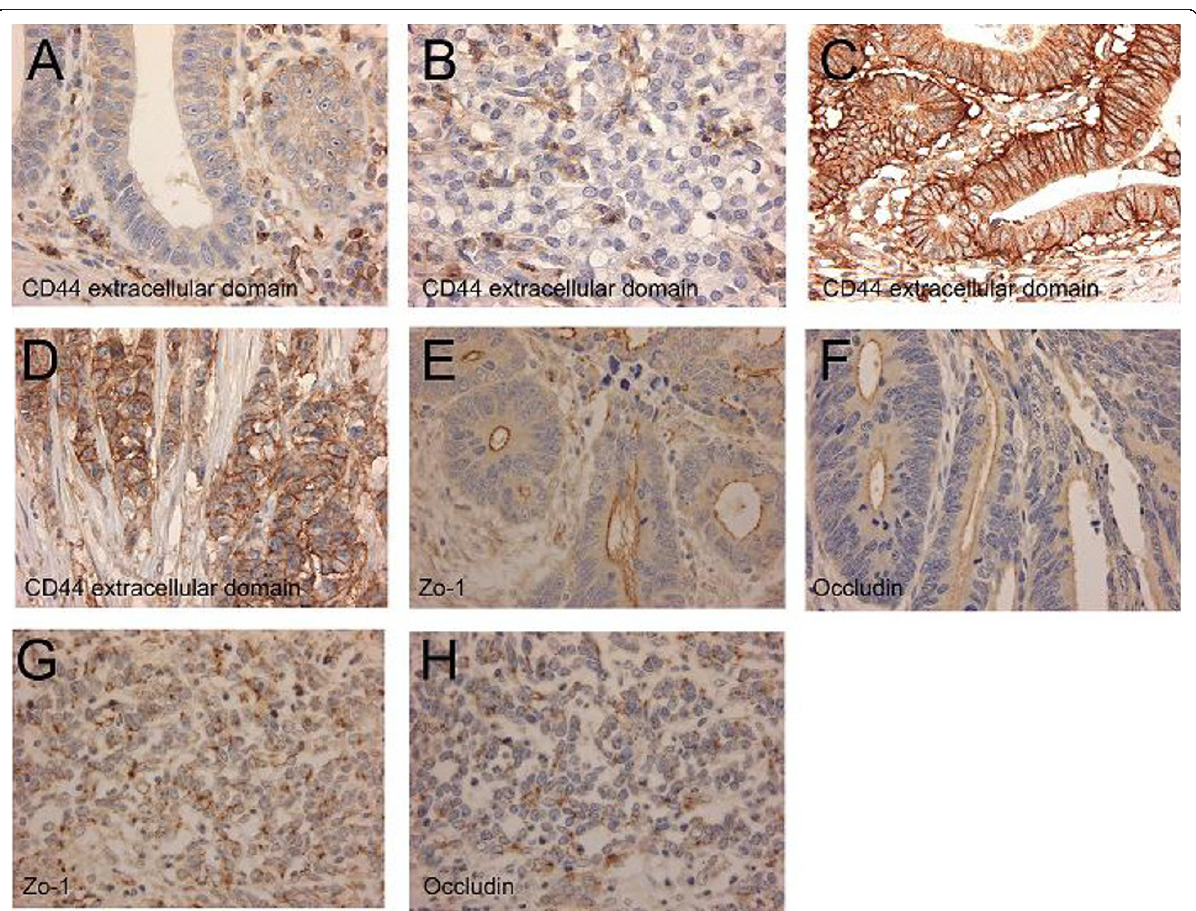
Figure 2 Representative photographs of CD44 extracellular domain, Zo-1, and occludin expression . CD44 extracellular domain is not expressed at the cell membrane of the invasive part of ulcerative colitis (UC)-associated well differentiated carcinoma (A) and a poorly differentiated carcinoma (B). On the other hand, in a case of sporadic well differentiated (C) and a case of sporadic poorly differentiated adenocarcinoma (D), membranous expression of CD44 extracellular domain is observed. Linear expression of Zo-1 (E) and occludin (F) is seen at the luminal surface in a case of UC-associated well differentiated carcinoma. However, in a UC-associated poorly differentiated case, dot-like expression of both Zo-1 (G) and occludin (H) is observed on the cell surface.